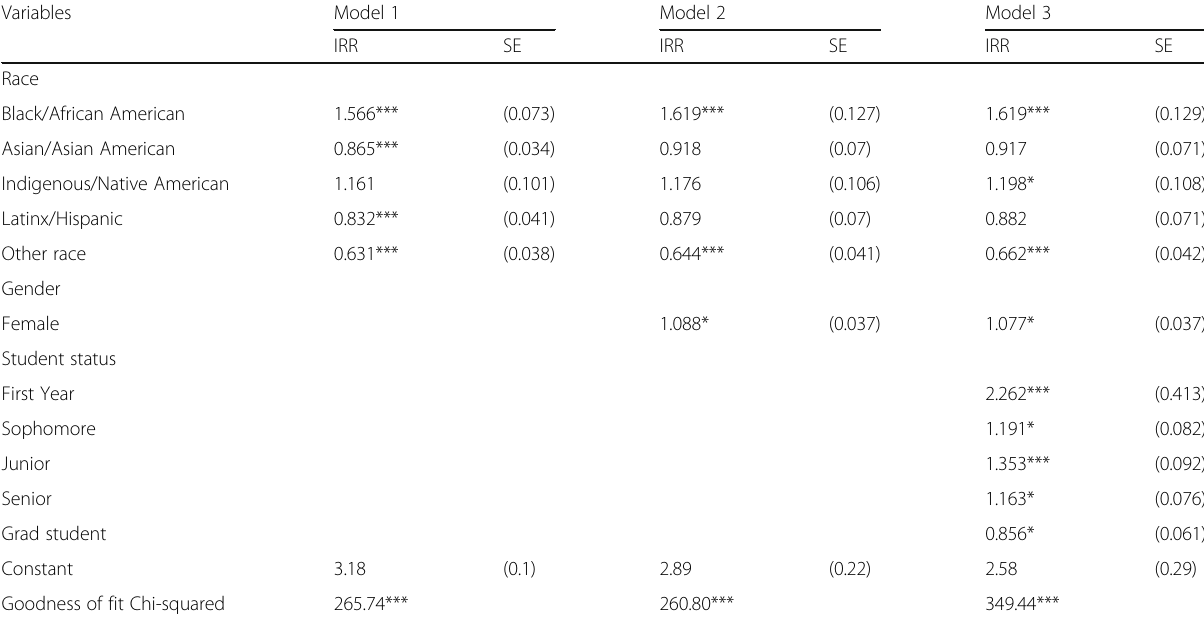
Table 4 Poisson regression predicting classroom level microaggressions for all STEM students